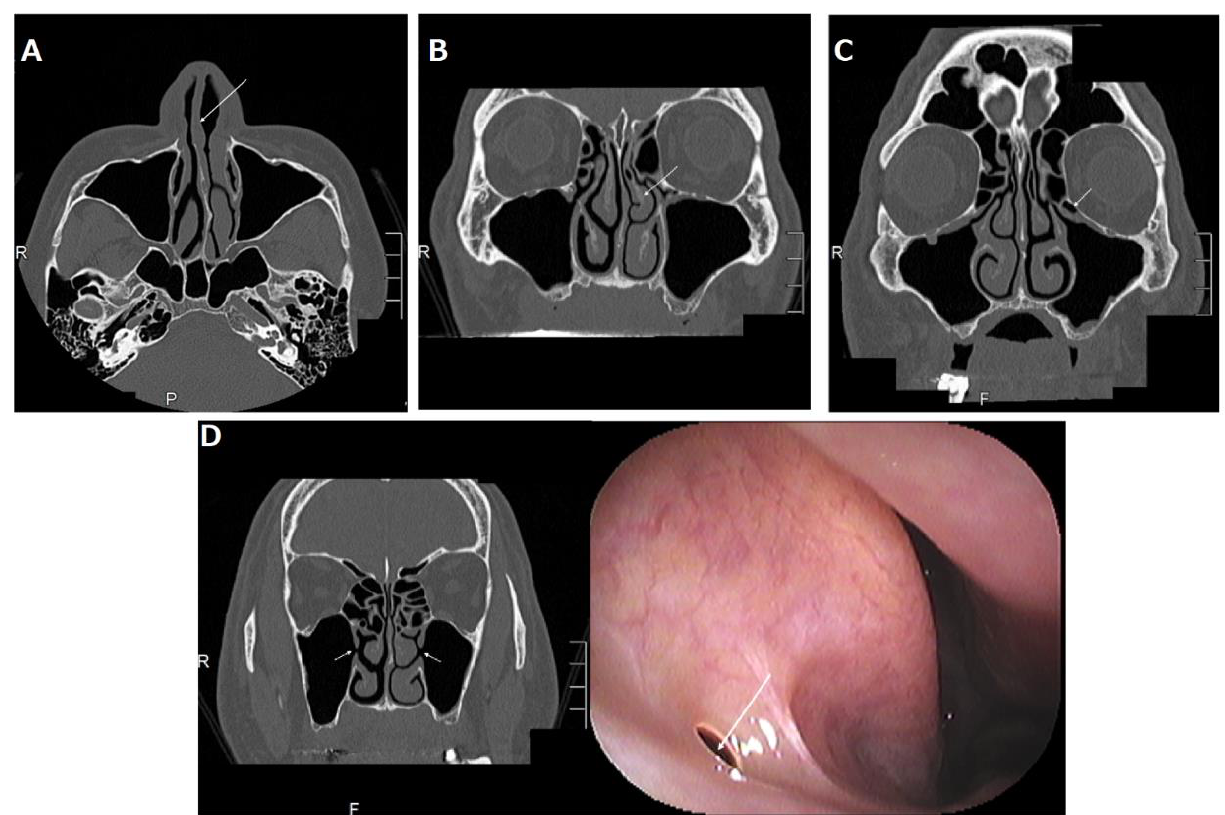
Figure 4. ( A ) Right nasal septal deviation (arrow); ( B ) left paradoxical middle turbinate (arrow) and left concha bullosa of the middle turbinate; ( C ) left Haller cell (arrow); ( D ) bilateral accessory ostium of the maxillary sinus (arrow in CT (left panel)) and right accessory ostium (arrow in nasal endoscopic examination (right panel)). This was originally published in Case Reports in Otolaryngology : Suzuki-Yamazaki, M.; Takahashi, K.; Takada, S.; Kato, Y.; Baba, Y. “A successful treatment regimen for the prevention of sinusitis after maxillary sinus floor elevation surgery in a high-risk case.” Case